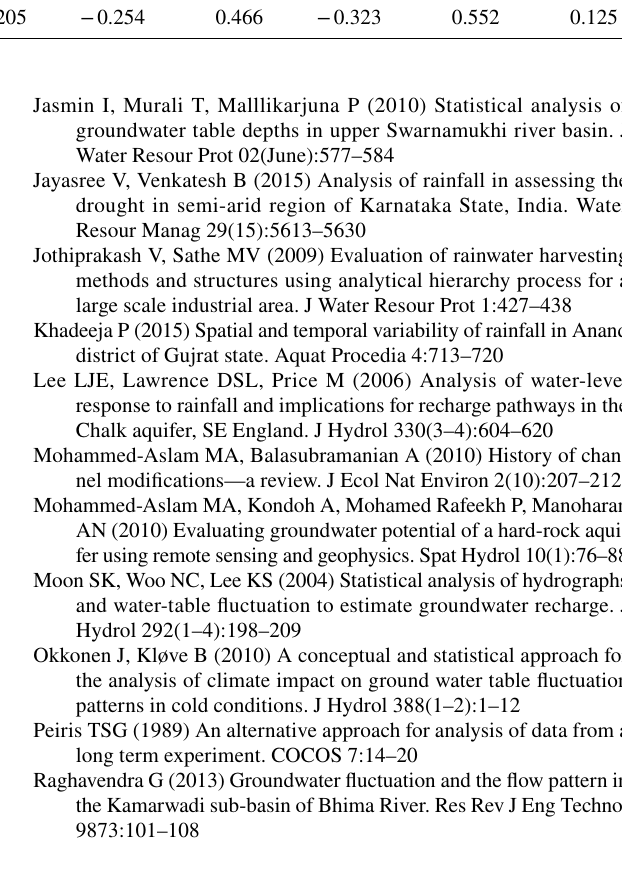
Table 8 Correlation between rainfall and water-table records